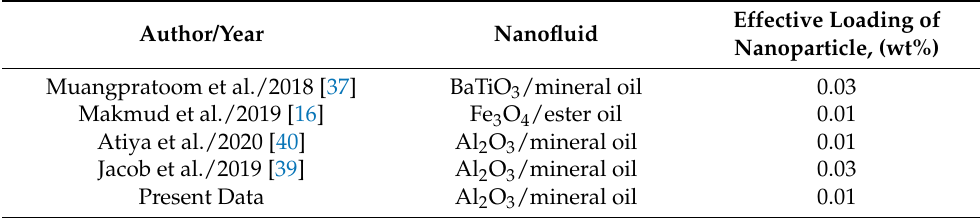
Table 4. Comparison of the present experimental data of type nanofluids and effective loading of nanoparticles in respect to PD